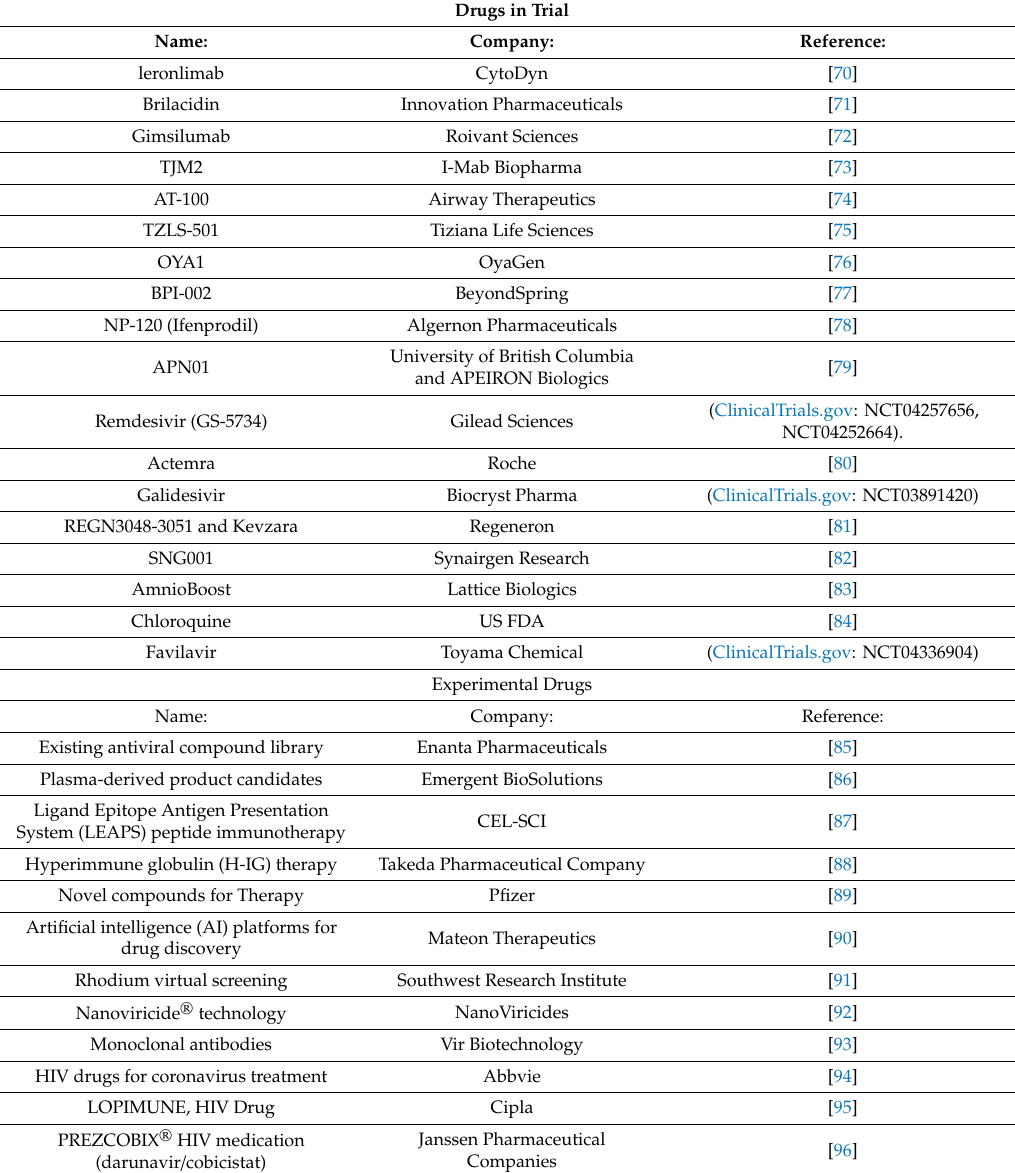
Table 2. A comprehensive list of therapies in development for COVID-19. Drugs in